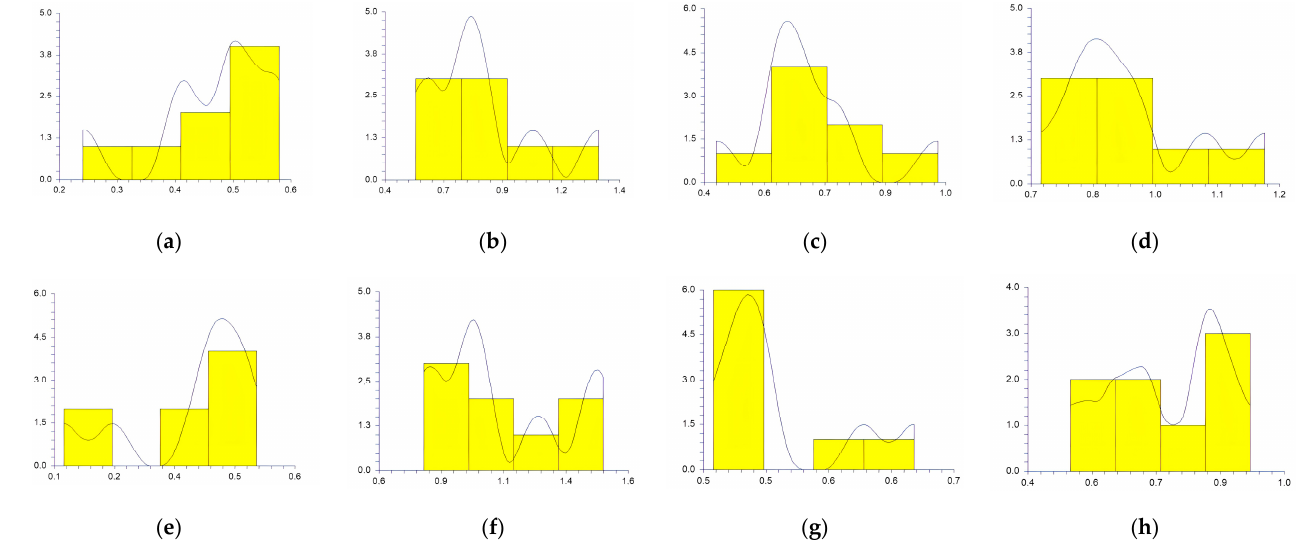
Figure 6. The chamfer width obtained at the reference points by all the participants Thursday: ( a ) t1 sitting position; ( b ) t2 sitting position; ( c ) T1 sitting position; ( d ) T2 sitting position; ( e ) t1 supine position; ( f ) t2 supine position; ( g ) T1 supine position; ( h ) and T2 supine